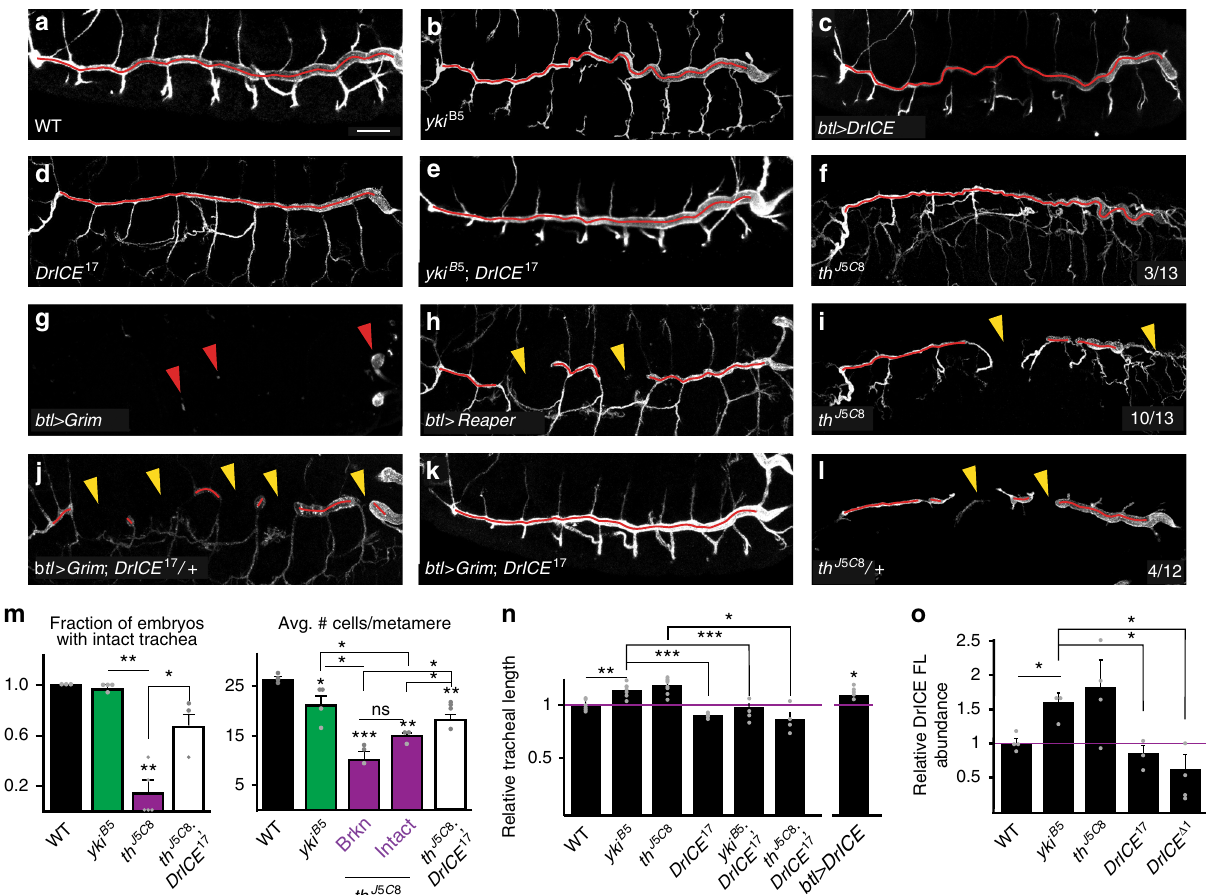
Fig. 1 DrICE governs tracheal size downstream of Yorkie without triggering apoptosis. a – l Compared to WT ( w 1118 ) ( a ), the dorsal trunks (DTs) of yki B5 mutant embryos ( b ), and those overexpressing DrICE in the tracheal system ( btl > DrICE ) ( c ) are elongated, while DTs in DrICE 17 are too short ( d ). DrICE 17 is epistatic to yki B5 since yki B5 ; DrICE 17 double mutants do not have long trachea ( e ). Loss of the DrICE inhibitor Diap1/ th can cause tracheal overelongation ( f ) or missing DT segments when homozygous ( i ) or heterozygous ( l ). Expression of the pro-apoptotic genes btl>Grim ( g ) or btl>Reaper ( h ) causes segment loss dependent on DrICE 17 dosage ( j , k ). Red arrows in g mark remnants of the tracheal system, while yellow arrowheads in h – l mark missing dorsal trunk segments. Scale bar for a – l in a , 25 μ m. m Loss of Diap1 ( th J5C8 ) decreases the number of embryos with intact dorsal trunks ( N = 17 embryos over fi ve experiments) and the number of tracheal cells ( N = 6 embryos total: 3 broken, 3 intact), indicating apoptosis. The loss of intact trachea and overall cell numbers can be suppressed by DrICE 17 ( N = 20 over three experiments and N = 4, respectively). Neither cell death nor dorsal trunk breaks are present in yki B5 embryos ( N = 4). n DT length in single and double mutant combinations of HN and DrICE mutants. DT length normalized to WT ( w 1118 ) ( N = 10) for HN and DrICE mutants, and to btl-Gal4, UAS-GFP/ + for overexpressed DrICE ( btl-Gal4 UAS-GFP/ + ; UAS-DrICE/ + ) ( N ≥ 5 for all except N = 4 for th J5C8 ;DrICE 17 ). o Western blot of stage 16 embryos using the α -DrICE CST13085 antibody, which recognizes full-length DrICE. A representative blot is shown in Supplementary Fig. 1i. The 47 kDa DrICE full-length band was quanti fi ed relative to total protein from at least three experiments. DrICE protein levels in DrICE 17 homozygotes are not different than WT, consistent with DrICE 17 being a dominant negative allele that causes more severe tracheal phenotypes than DrICE Δ 1 18 ( n , o ). ( N = 4 blots). All source data are provided in the source data fi le. For all graphs, each data point is indicated as a point. Error bars, S.E.M. * p < 0.05; ** p < 0.005; *** p < 0.0005 Student ’ s t